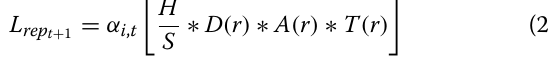
them having different reputations. Reputation is whether the computing party’s behavior is honest or not after each round of tasks. In general, the computing party has two reputation statuses: honest or malicious. Specifically, when the computing party’s reputation in round t + 1 is ≥ L higher than that in round t , i.e. L rep rep t , we consider t + 1 the computing party to be honest. On the contrary, when the computing party’s reputation in round t + 1 is lower ≤ L than round t , i.e. L rep rep t , we consider the comput- t + 1 ing party to be malicious. The evaluation of reputation is shown in formula 2